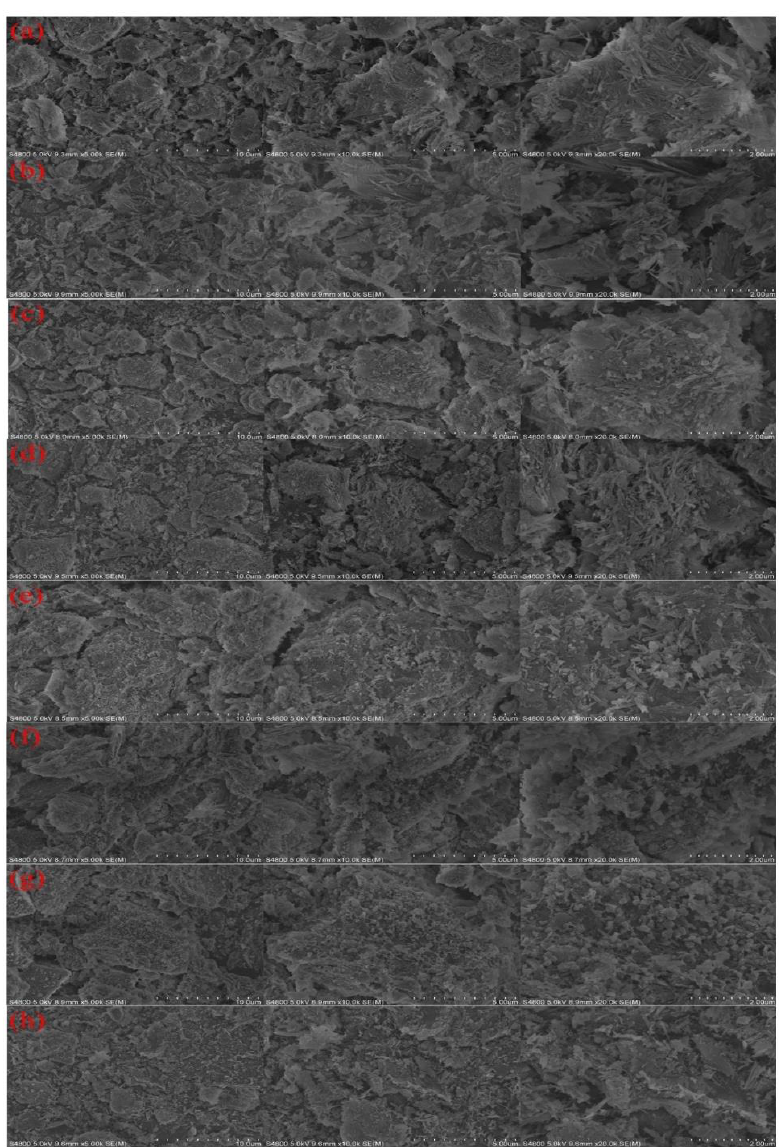
Figure 1. SEM of Mn/Zn@PG catalyst: ( a ) blank; ( b ) 100 °C; ( c ) 250 °C; ( d ) 400 °C; ( e ) 550 °C; ( f ) 700 °C; ( g ) 850 °C; ( h ) Mn/Zn@PG after utilization 20 times.